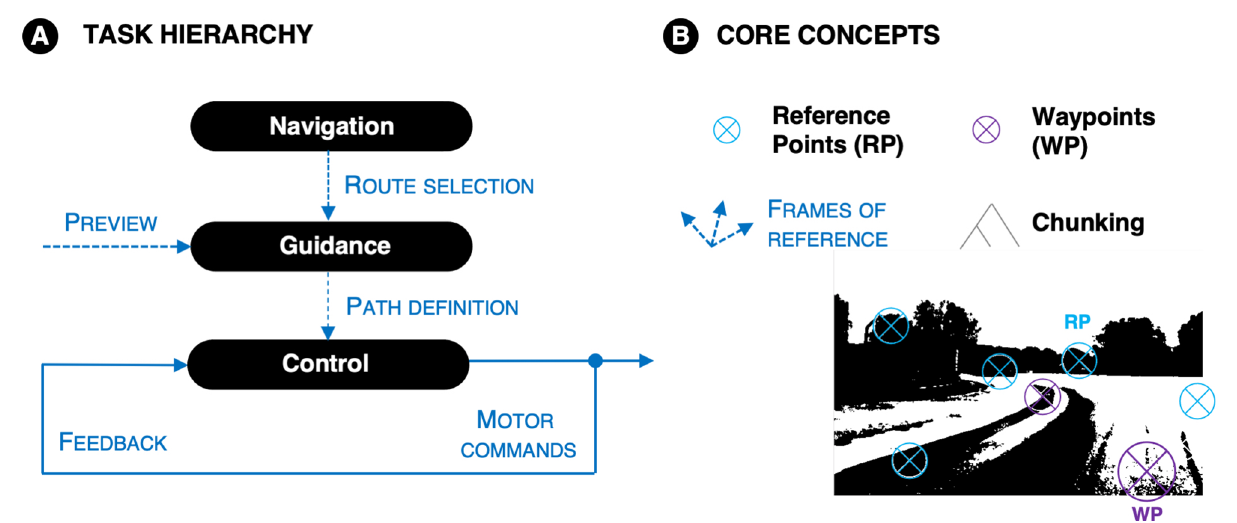
FIGURE 2 | (A) The McRuer hierarchy. Navigation: choosing the desired path among alternatives. Guidance: definition of the desired future path based on visual preview. Control: steering and speed control by motor routines adapted to body/vehicle dynamics. Based on sensory feedback and feedforward control based on the top-down path definition. (B) Core concepts. Reference points: visual landmark features that can be recognized and used in self-localization. Waypoints: fixed objects or locations that are interception targets for self-motion. Frames of reference and transformations; different cognitive processes trade on information in different coordinate systems (allocentric, egocentric). Chunking: grouping elements into patterns that can be recognized and used to guide action. Expertise is based on having both more and bigger chunks stored in